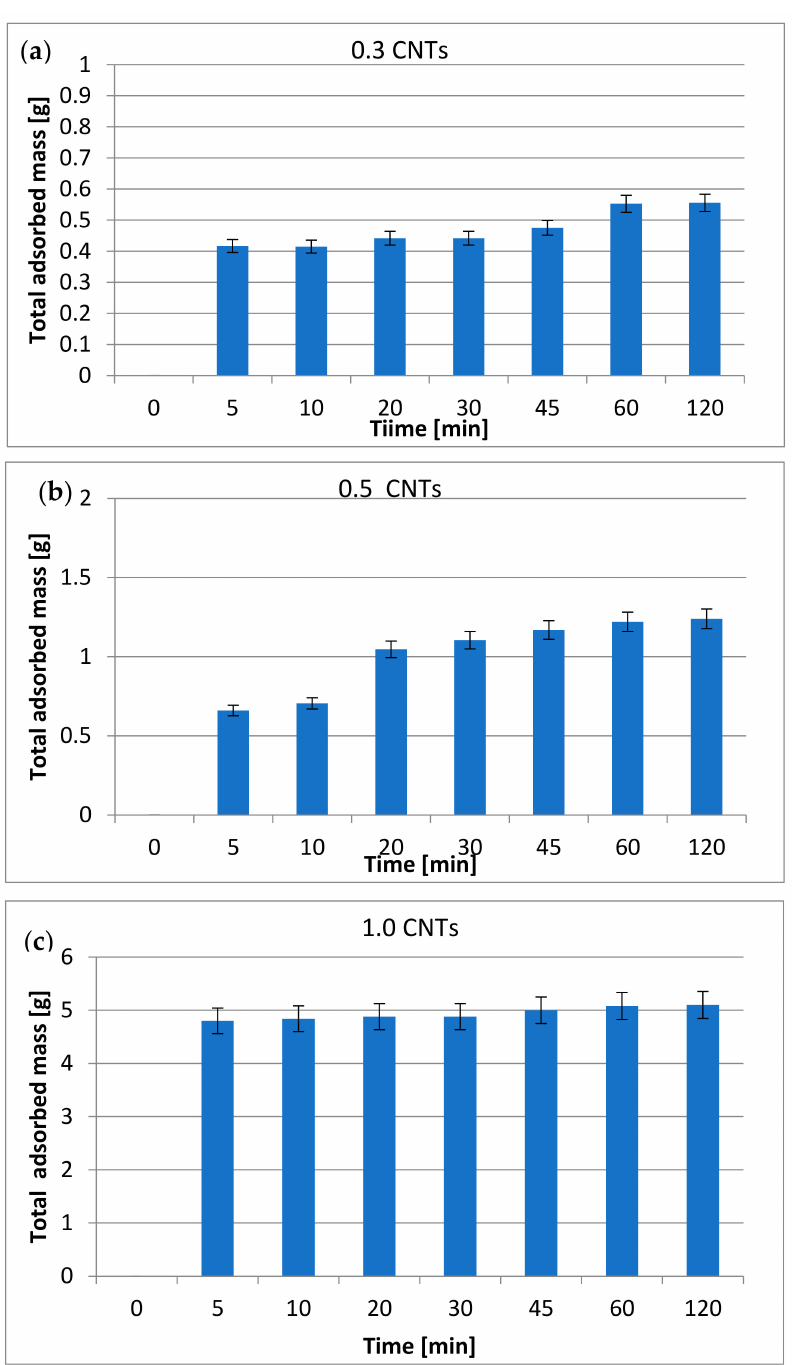
Figure 2. Total adsorbed mass of the carbon nanotubes after the adsorption tests as a function of the treatment times for systems 1, 2 and 3, respectively, characterized by ( a ) 0.3, ( b ) 0.5 and ( c ) 1.0 g of carbon